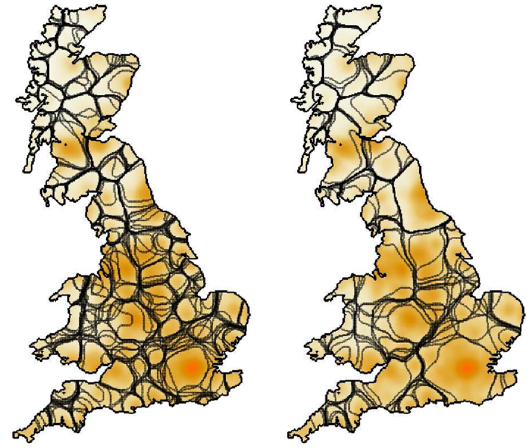
FIG. 6. Superposition of the isoglosses at t ¼ 50 produced by 20 solutions of the V ¼ 2 model with β ¼ 1 . 1 , each with different randomized initial conditions. For the left-hand map, σ ¼ 5 km, and for the right-hand map, σ ¼ 10 km (see video in Supple- mental Material [38]). Background shading indicates population density with brightest orange corresponding to 7200 inhabitants per km 2 .